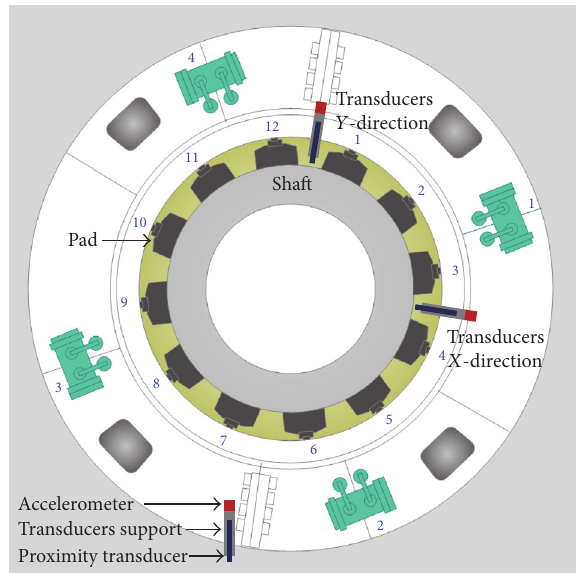
Figure 2: Vibration transducers arrangement in the turbine journal